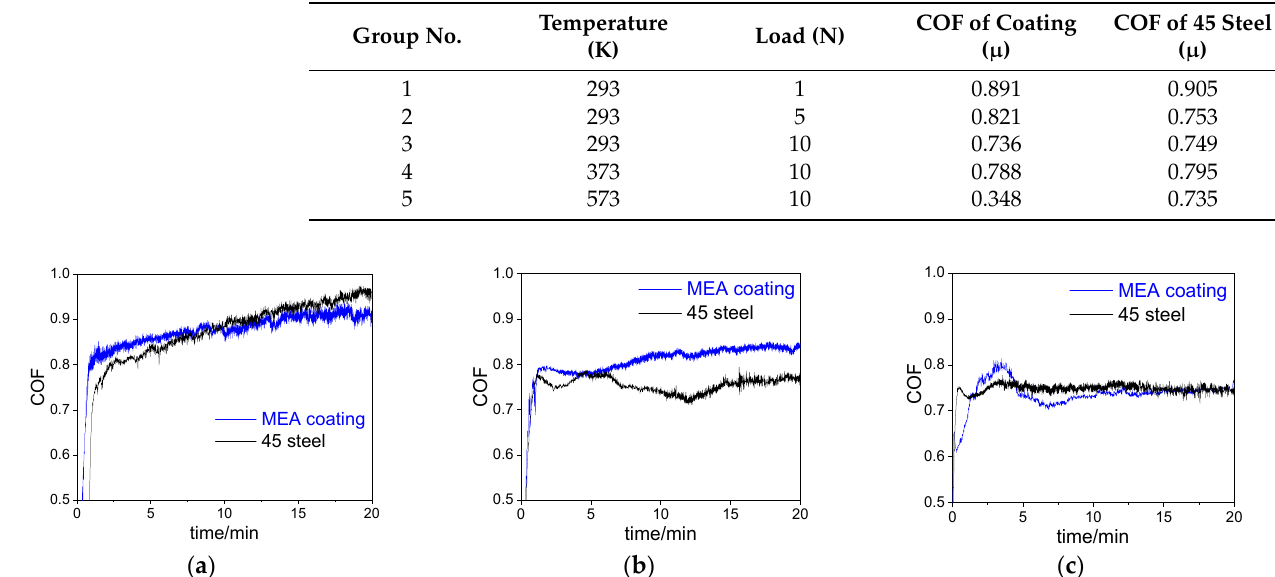
Figure 5. Friction coefficient curves at different loads (RT): ( a ) 1 N; ( b ) 5 N; ( c )10 N.